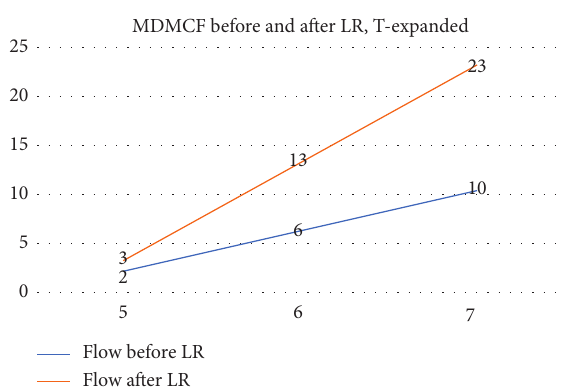
Figure 6: Comparison of flow before and after lane